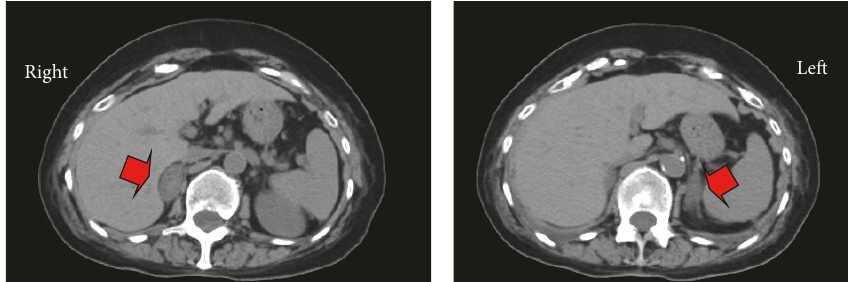
Figure1: Abdomen CTshowing bilateral adrenal enlargement, highlighted byred arrows,with ahyperdensecentral area of2 cmof maximum diameter (HU 25–35) in right adrenal gland.